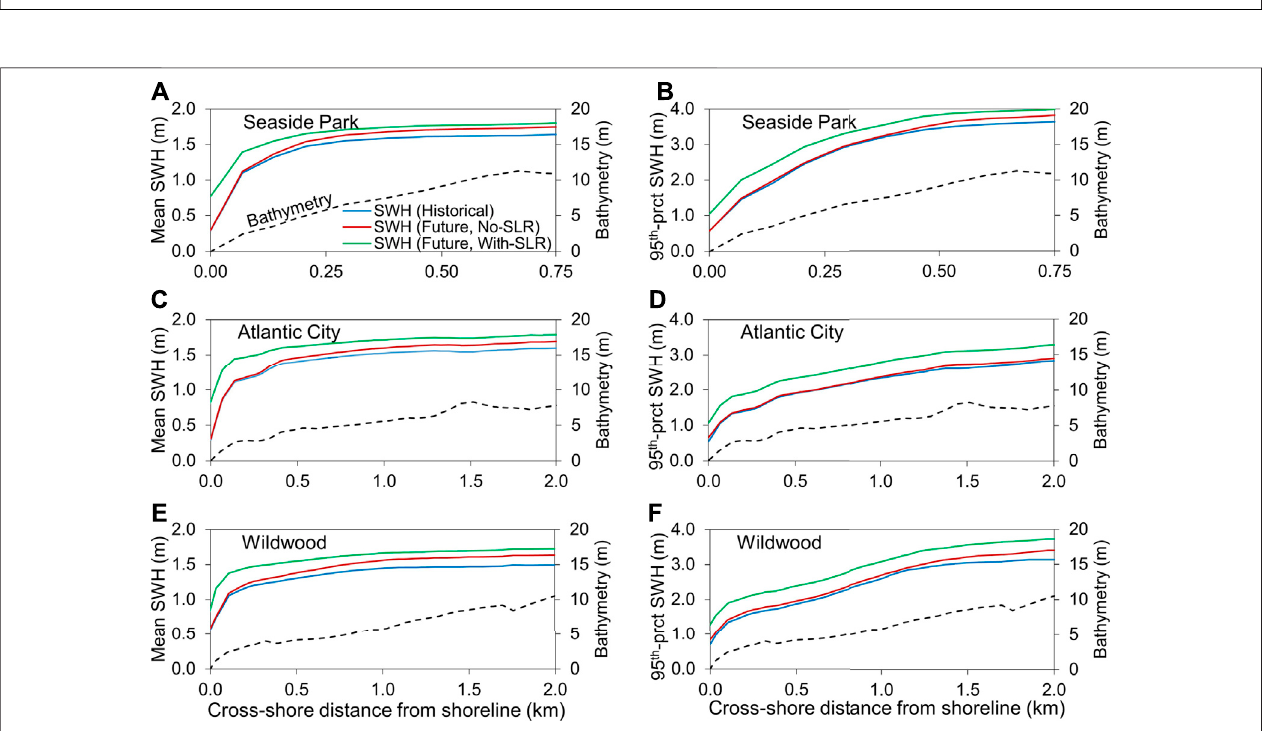
FIGURE 8 | Cross-shore pro fi les of (A – C) mean and (D – F) 95th-percentile SWH along the three pro fi les shown in Figure 1 . The black dashed lines represent the bathymetry. The origin of distance in the x axis is the shoreline (mean sea level vertical datum) along the open coast of barrier islands.